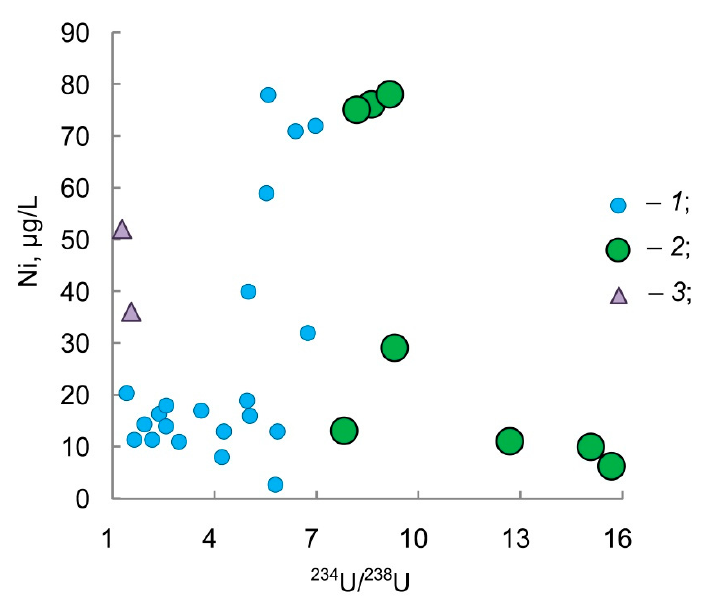
Figure 10. Relationship between the isotopic composition of uranium and nickel content in groundwater of the Pre-Volga region: 1 —points without anomalies of the isotopic composition of uranium ( 234 U/ 238 U < 7.8); 2 —points of anomalies of the uranium isotopic composition; and 3 — outliers.